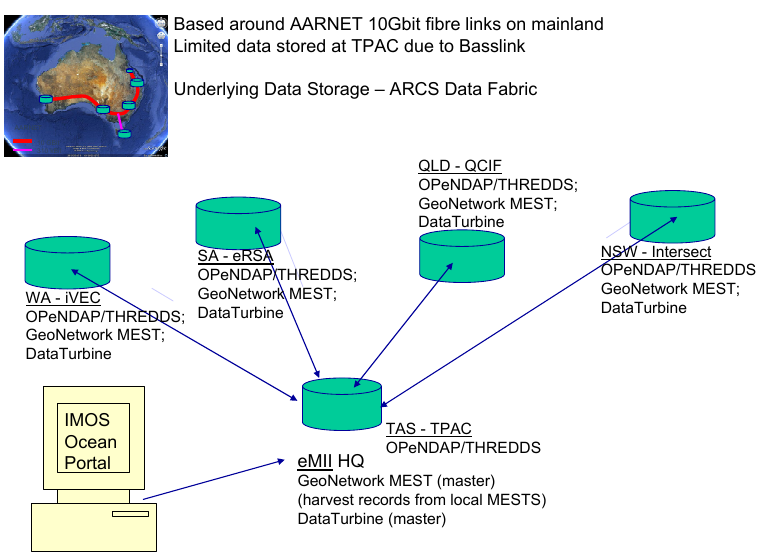
Figure 3 – The IMOS distributed data network